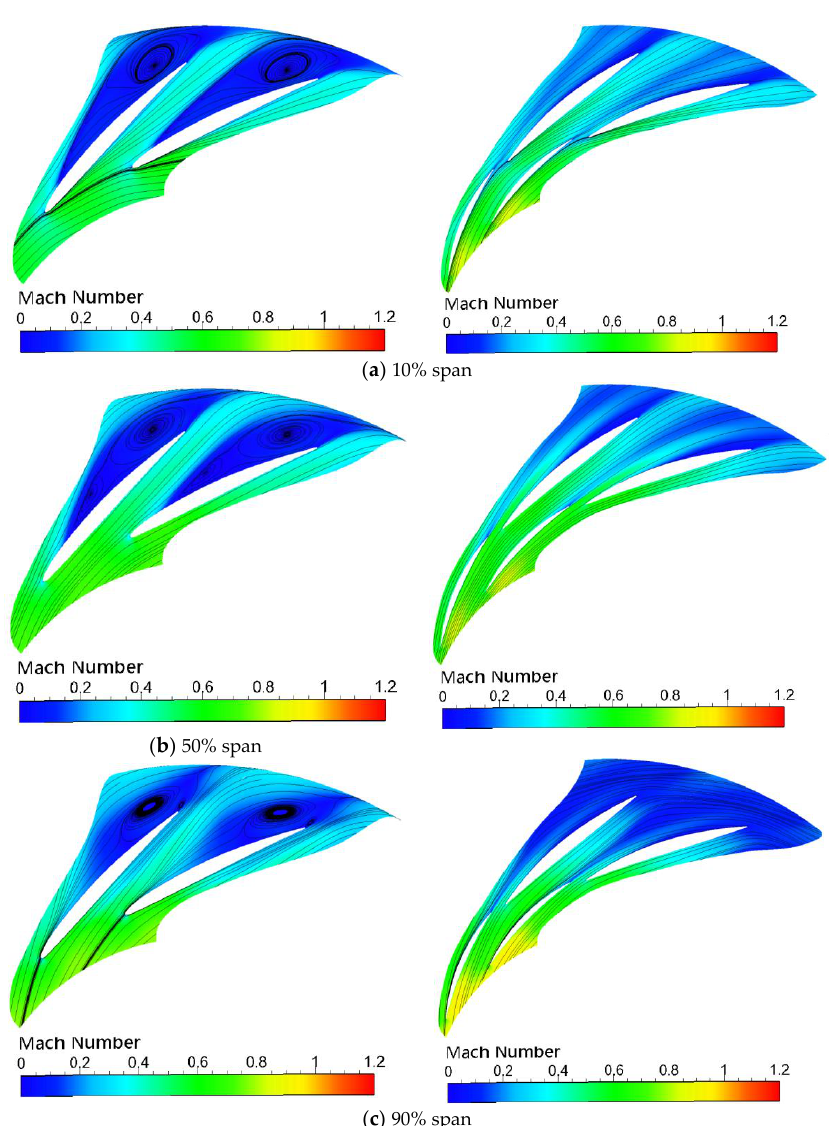
Figure 21. Mach number distribution at different spans of the original and optimized designs of the low-pressure-stage centrifugal compressor at 60% load.